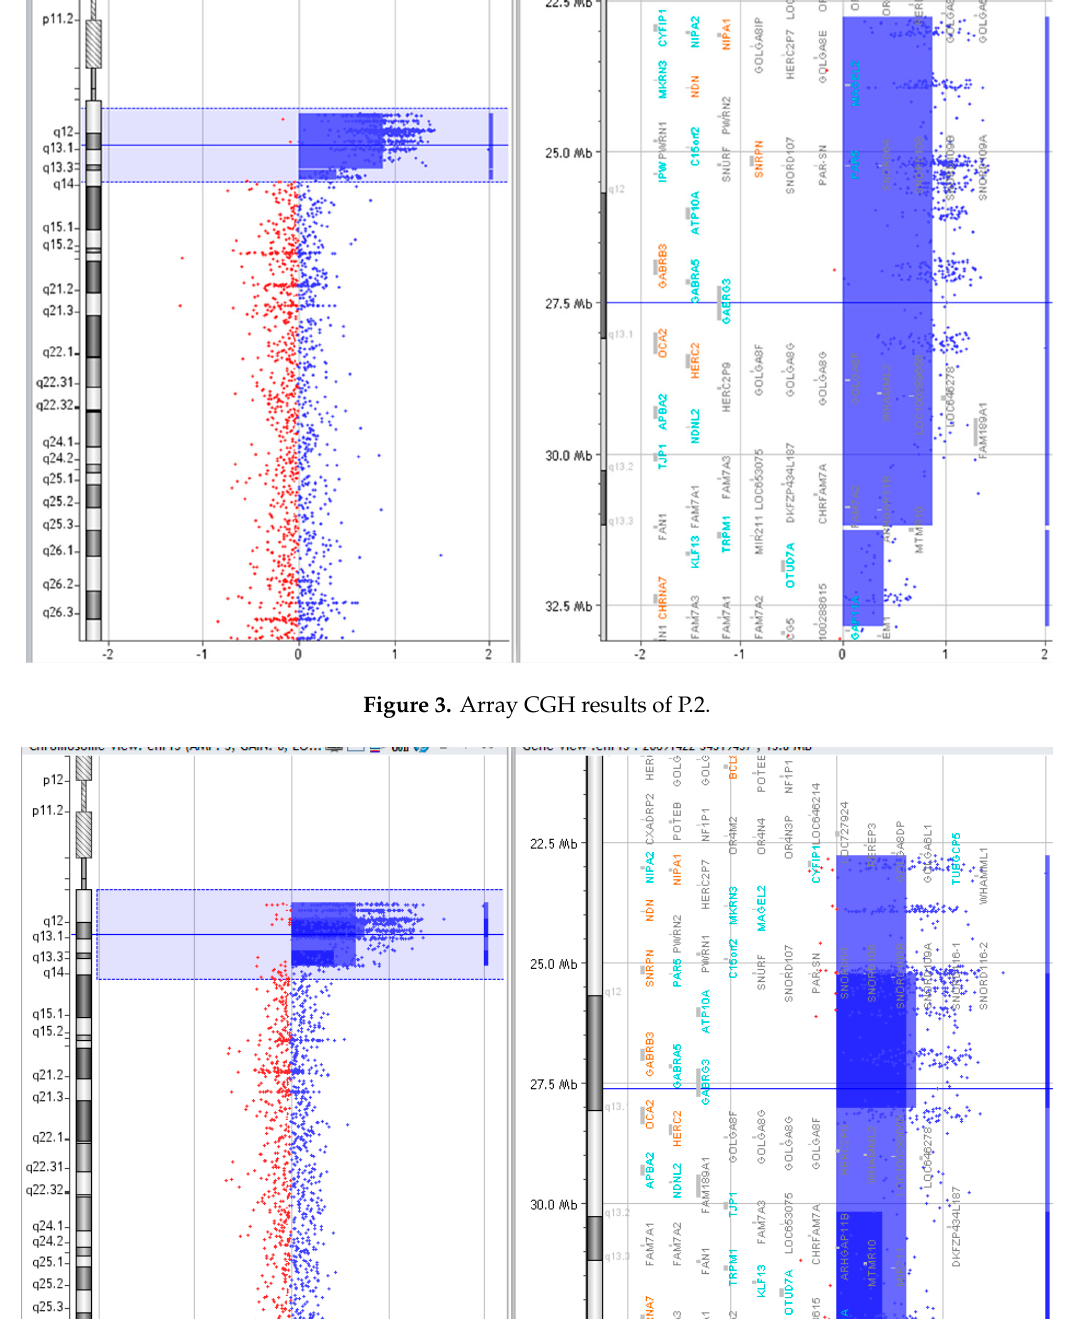
Figure 2. Array comparative genomic hybridization (CGH) results of P.1.